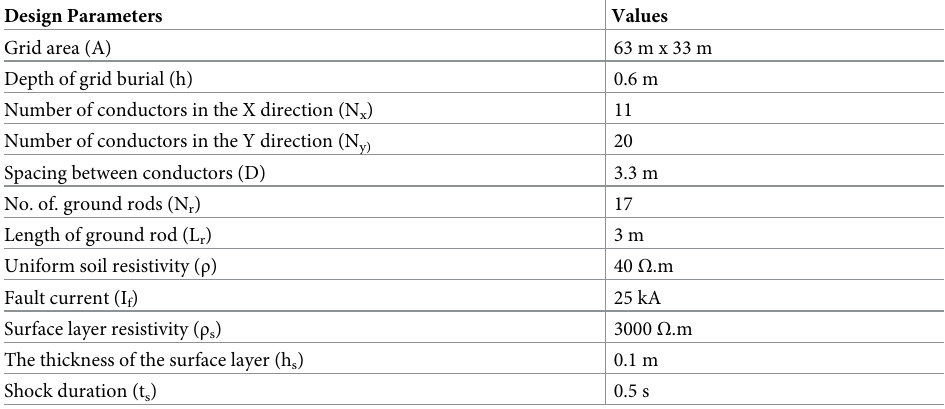
Table 5. Grounding system design input for uniform and horizontal two-layer soil structure [26].